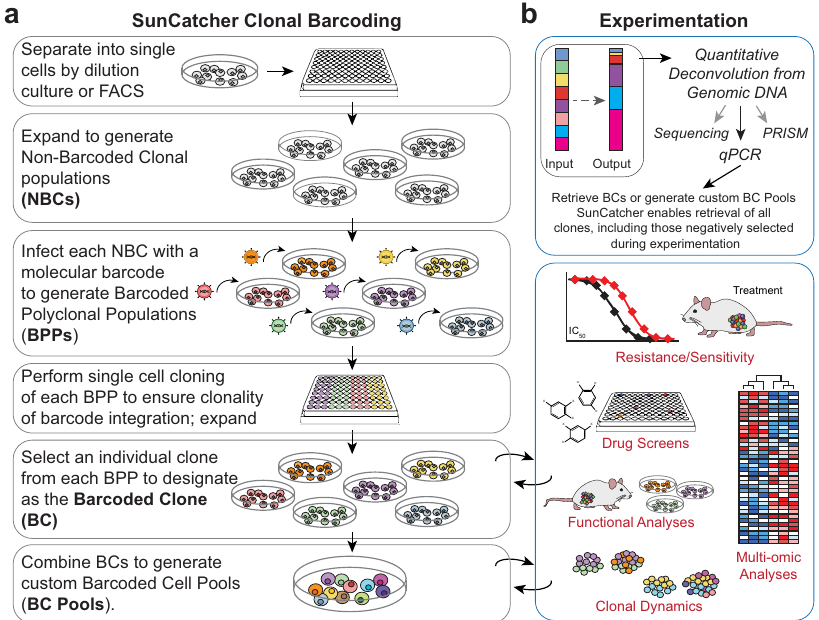
Fig. 1 SunCatcher clonal barcoding and functional analyses. a SunCatcher utilizes two rounds of single cell cloning to ensure that each subclone has only 1 unique barcode and that each cell within that subclone contains the same barcode insertion site. Due to the single cell cloning approach, custom BC pools of any combination can be designed. (FACS, fl uorescence-activated cell sorting; NBC, non-barcoded clone; BPP, barcoded polyclonal population (polyclonal for barcode insertion site); BC, barcoded clone; BC Pool, population containing multiple BCs). b BCs or BC Pools (input) can be entered into any experiment and detected at end point (output) using various deconvolution approaches. Deconvolution by quantitative polymerase chain reaction (qPCR) provides a cost-effective, rapid, and highly sensitive method for detecting and quantifying BCs. SunCatcher enables retrieval of all clones, including those negatively selected during experimentation, for further analyses and/or design and testing of custom BC fi rst isolating genomic DNA and PCR-amplifying common